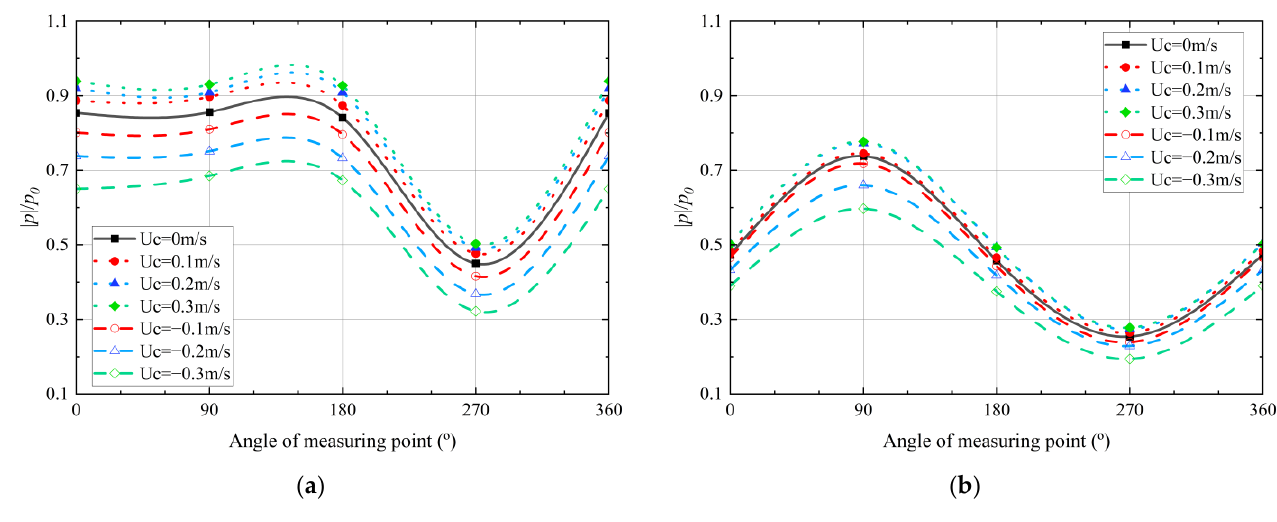
Figure A1. Variation of the dimensionless pore pressure amplitude around the pipeline with different backfill depths (e/D = 1/2, 3/2) and current velocities. ( a ) e/D = 1/2; ( b ) e/D = 3/2.